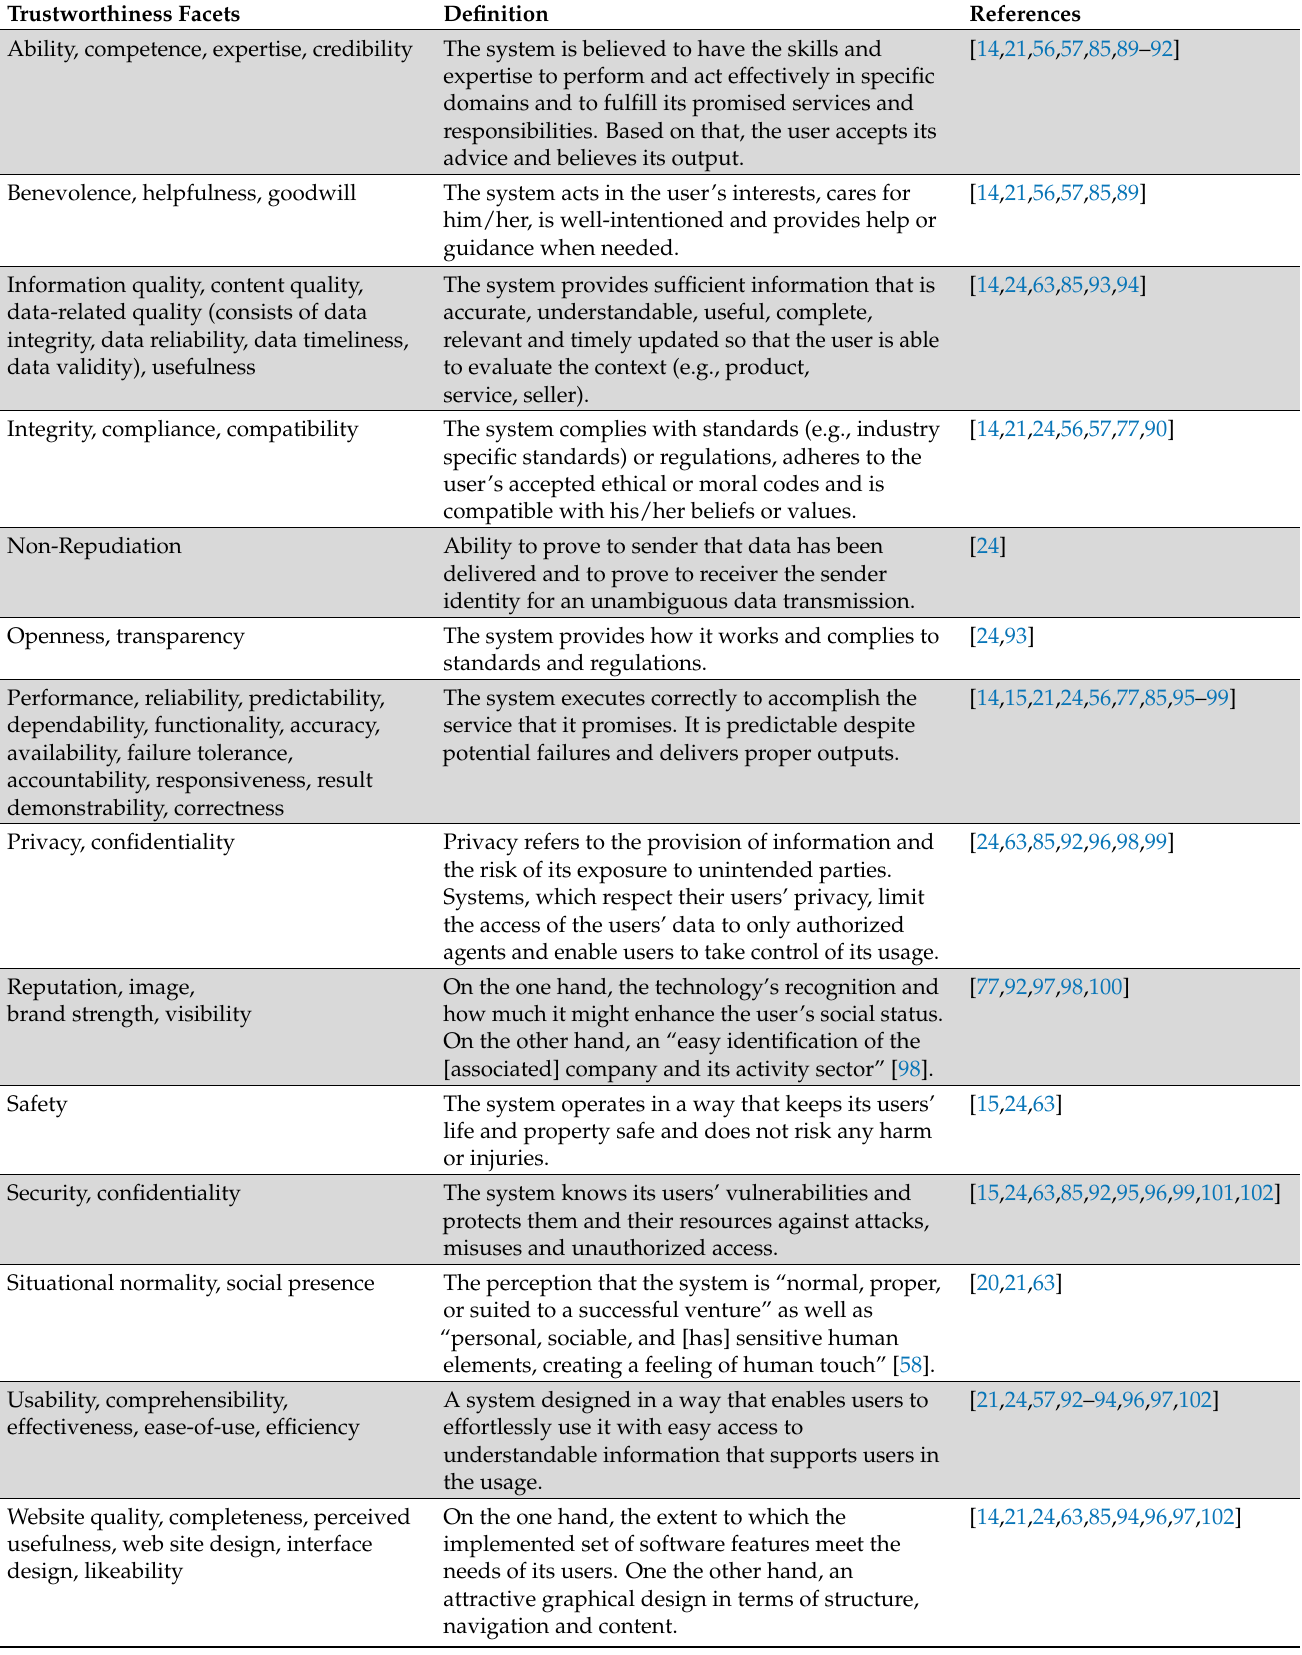
Table A2. Overview of the trustworthiness facets of